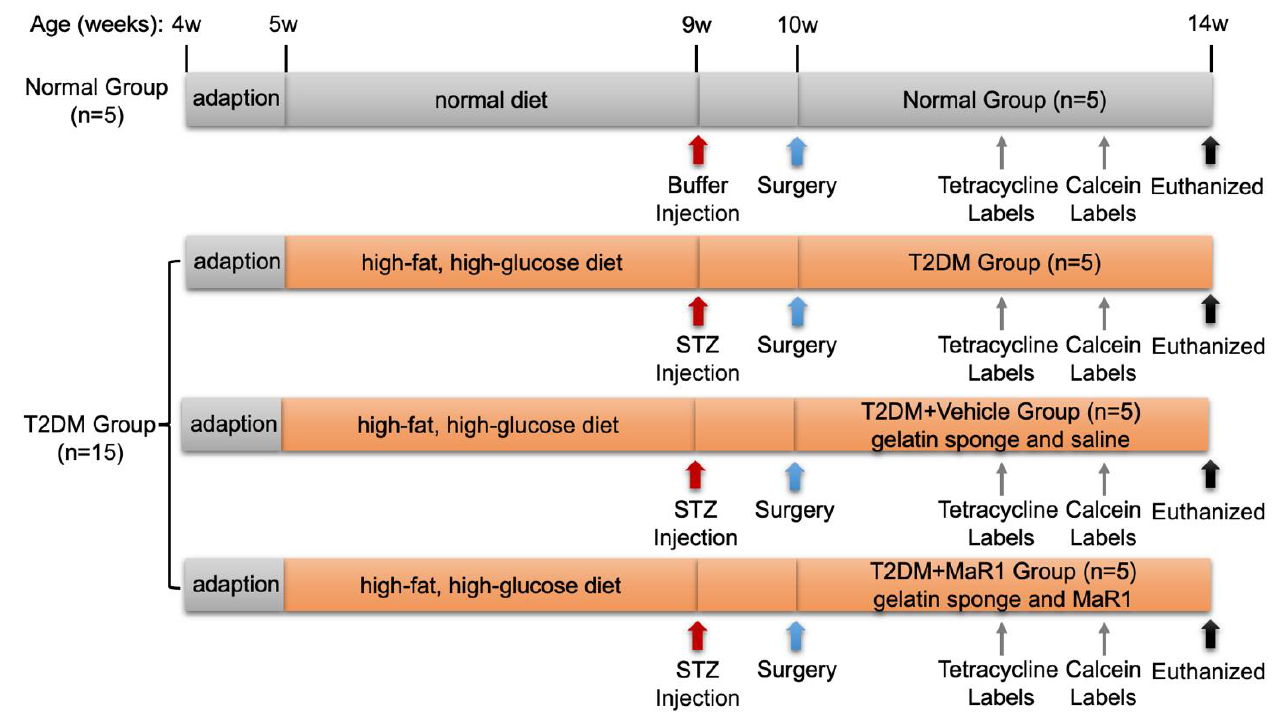
Figure A6. Illustration of the experimental design in vivo. Buffer: sodium citrate buffer; STZ: streptozotocin.